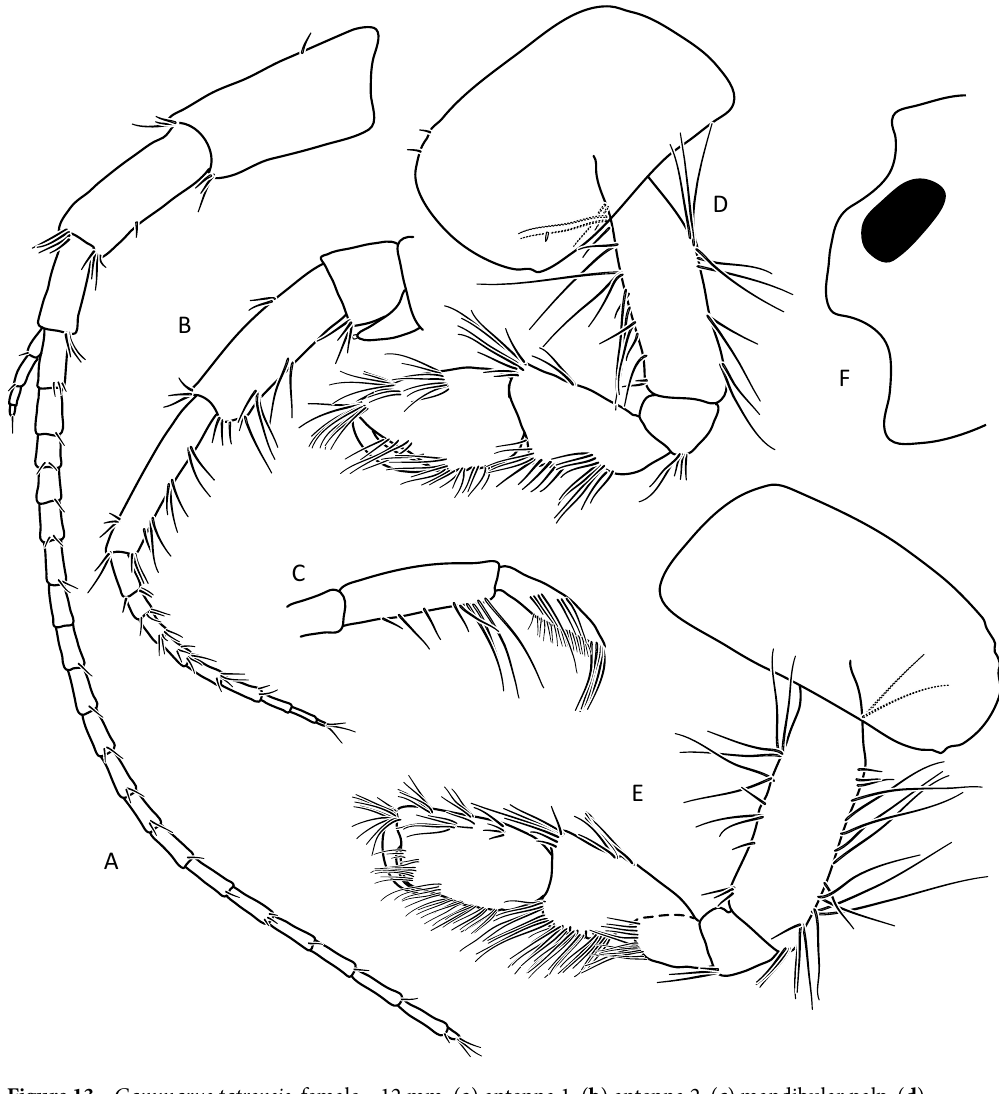
Figure 13. Gammarus tatrensis , female—12 mm. ( a ) antenna 1, ( b ) antenna 2, ( c ) mandibular palp, ( d ) gnathopod 1, ( e ) gnathopod 2, ( f )